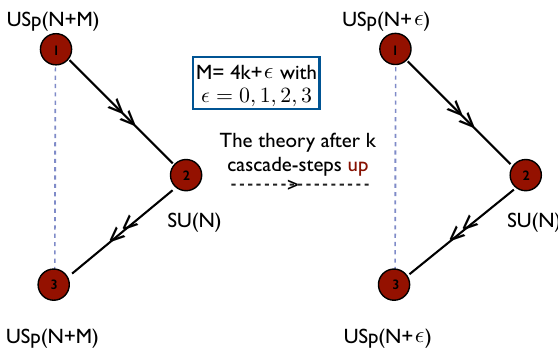
Figure 3 . The F 0 = (cid:10) theory with fractional branes. The inverse cascade. Di(cid:11)erent values of (cid:15) = 0 ; 1 ; 2 ; 3 de(cid:12)ne di(cid:11)erent UV completions. In the right quiver, we have renamed N 0 as N . A common feature of all four UV-completions, and the main qualitative di(cid:11)erence